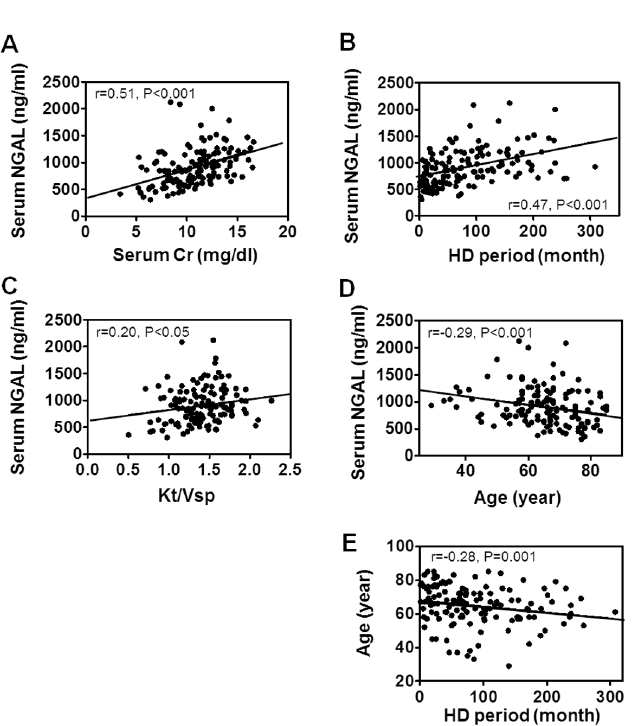
Fig 2. Linear correlation of baseline pre-dialysis serum NGAL levels with serum creatinine, dialysis efficiency, age and HD period. Correlations with ( A ) creatinine (Cr), ( B ) HD period, ( C ) single-pool Kt/V (Kt/ Vsp), and ( D ) age are shown. ( E ) Correlation between HD period and age. N = 139.